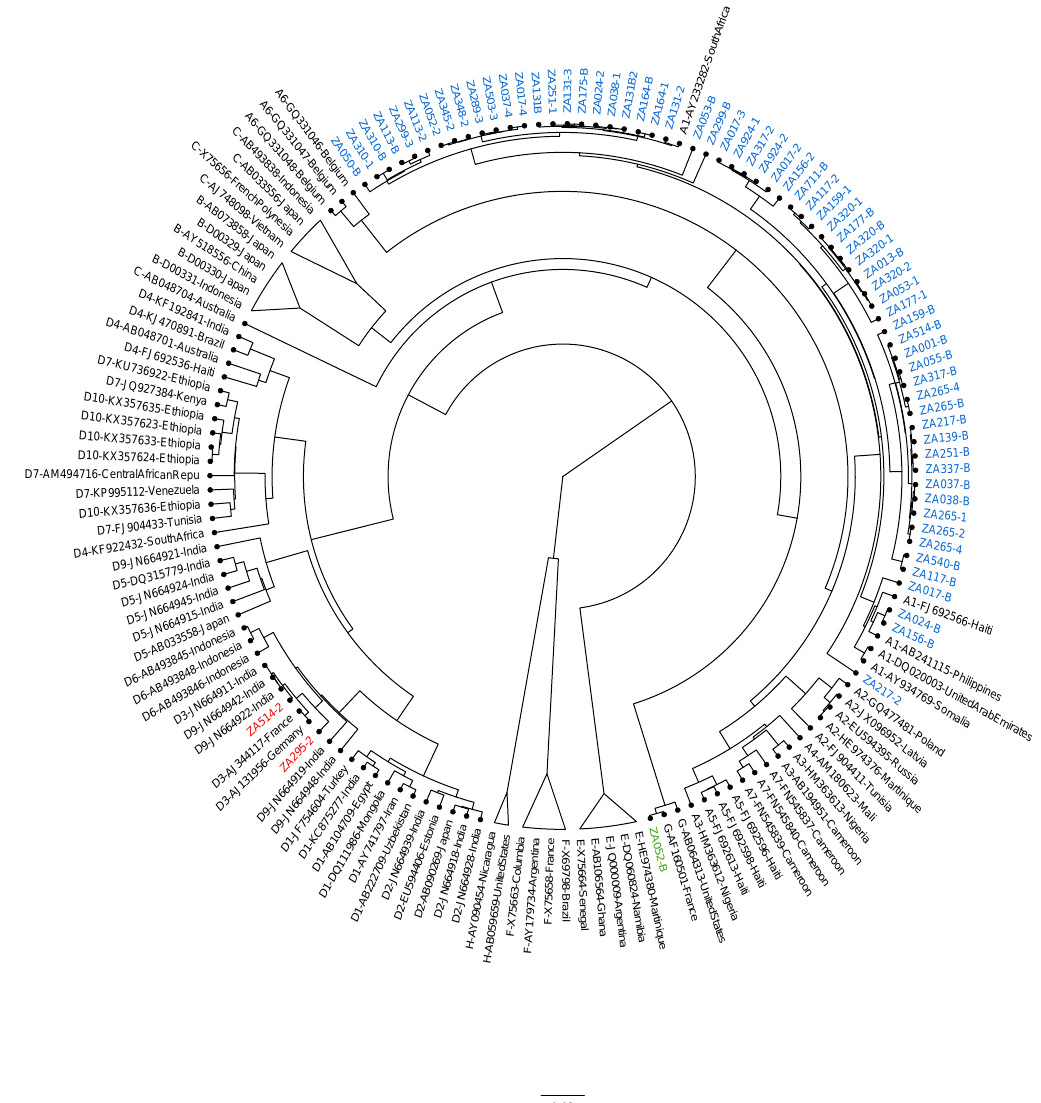
Figure 1. Phylogenetic analysis of HBV polymerase open reading from South Africans with occult or chronic HBV. Sequences from this study are indicted by “ZA”, while references are indicated by subgenotype–accession number–country. Genotype A sequences from this study are highlighted in blue, genotype D in red, and genotype G in